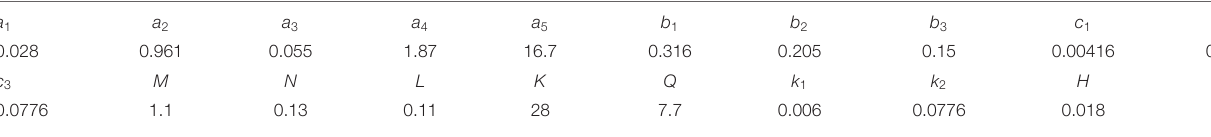
TABLE 4 | System coefficients after model